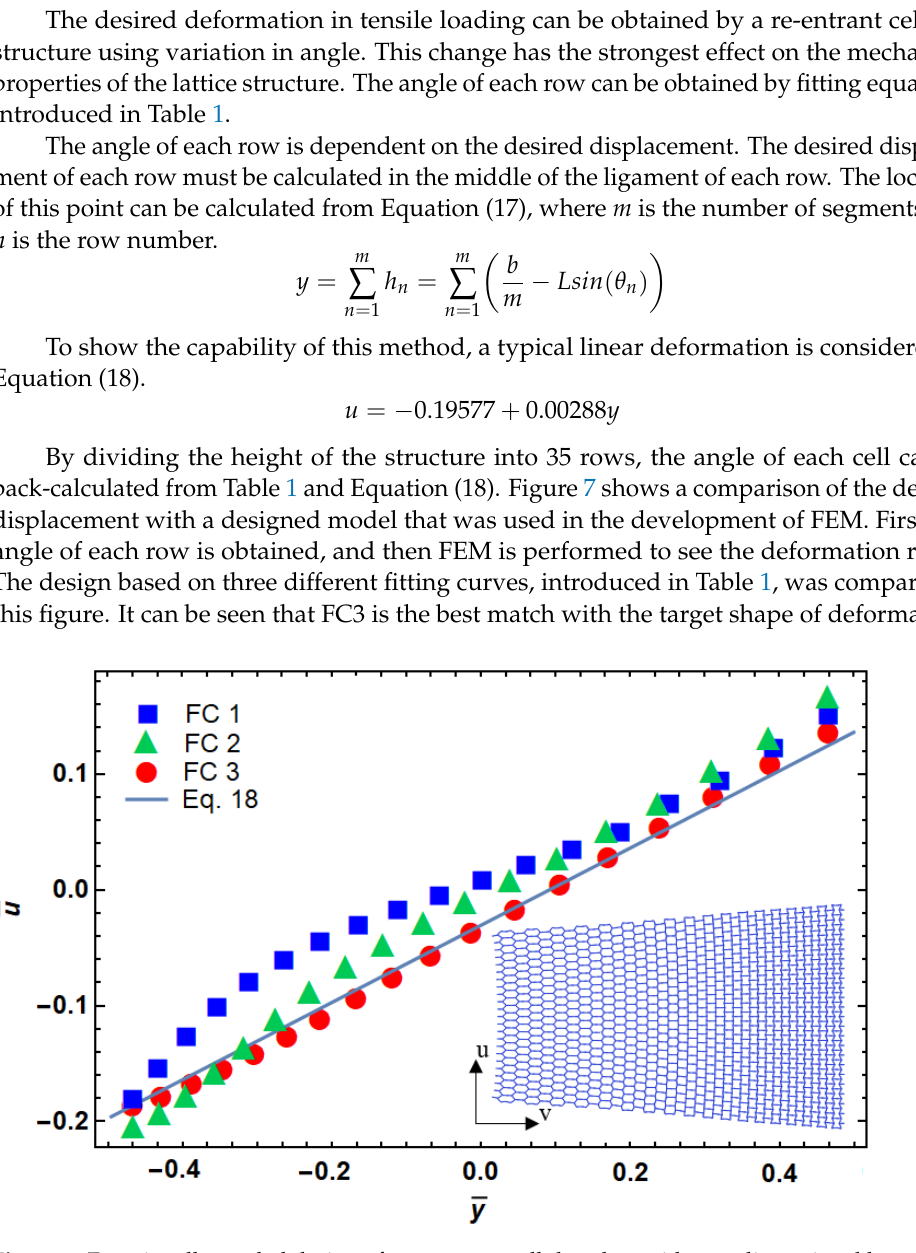
Figure 8. Comparison between the designed angle of cells with the presented approach and those obtained from experi- mental results presented in [17] for the desired deformation.